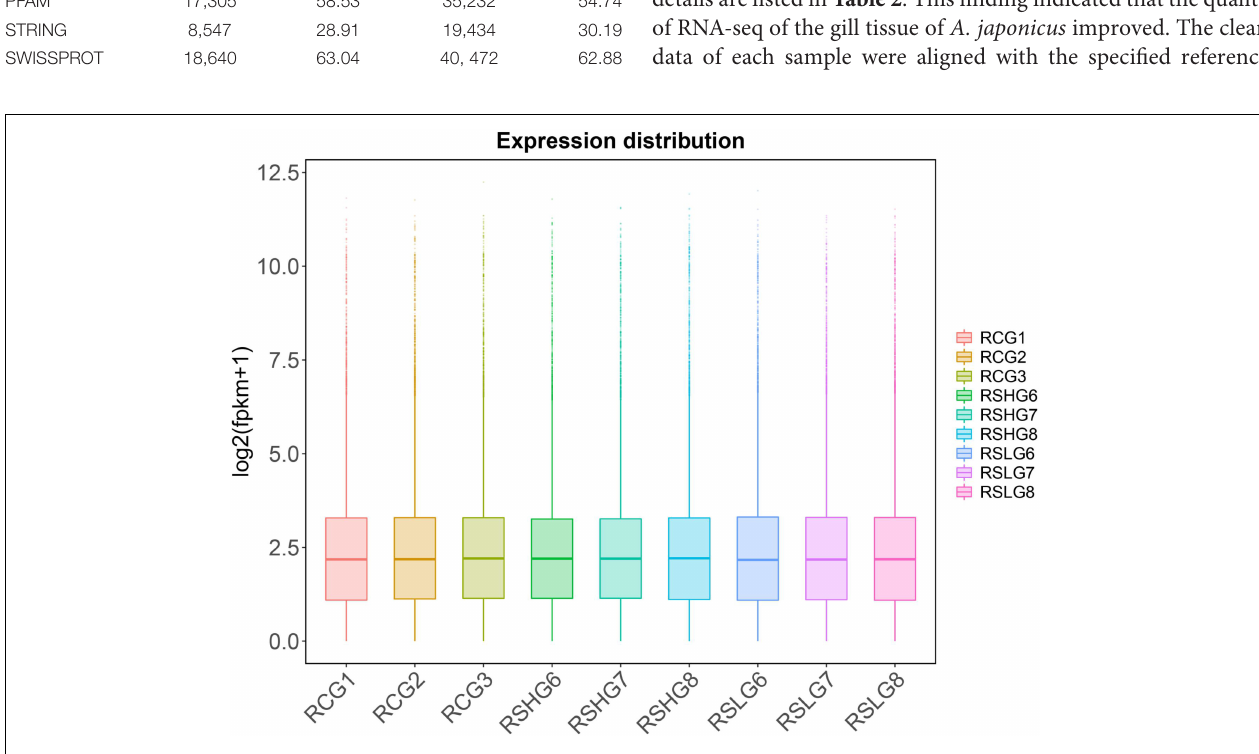
FIGURE 2 | Gene expression levels in different treatment